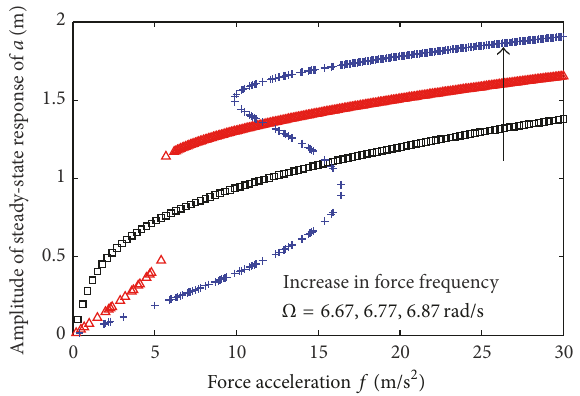
Figure 7: The effect of varying force frequency Ω on nonlinear stiffness response of vibration 𝑎 . Ω = 6.69 rad / s ( black squares), Ω = 6.73 rad / s (red triangles), and Ω = 6.77 rad / s (blue crosses).